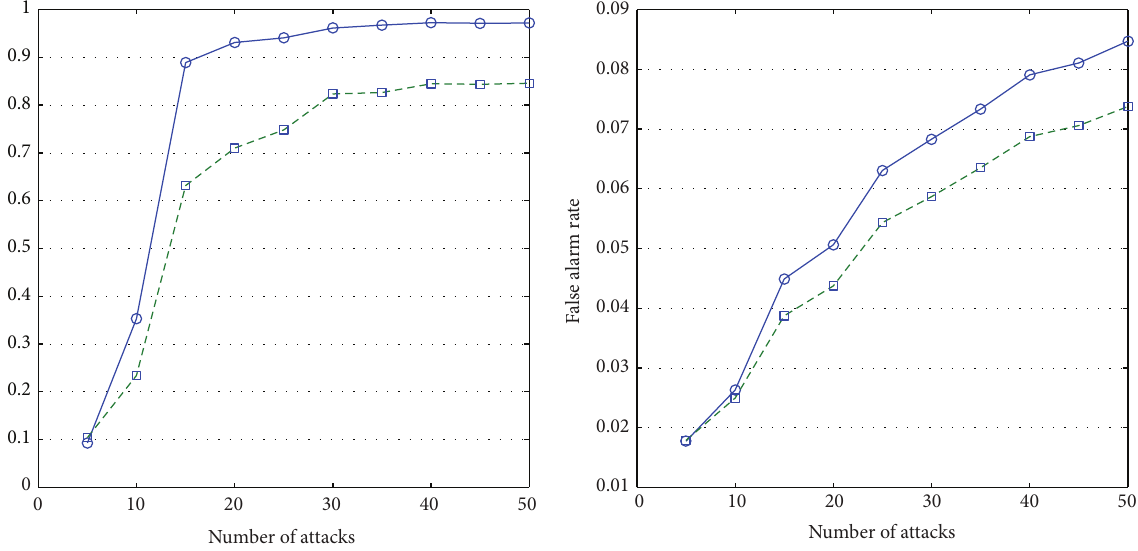
Figure 4: Detection rates and false alarm rates of the fad items.